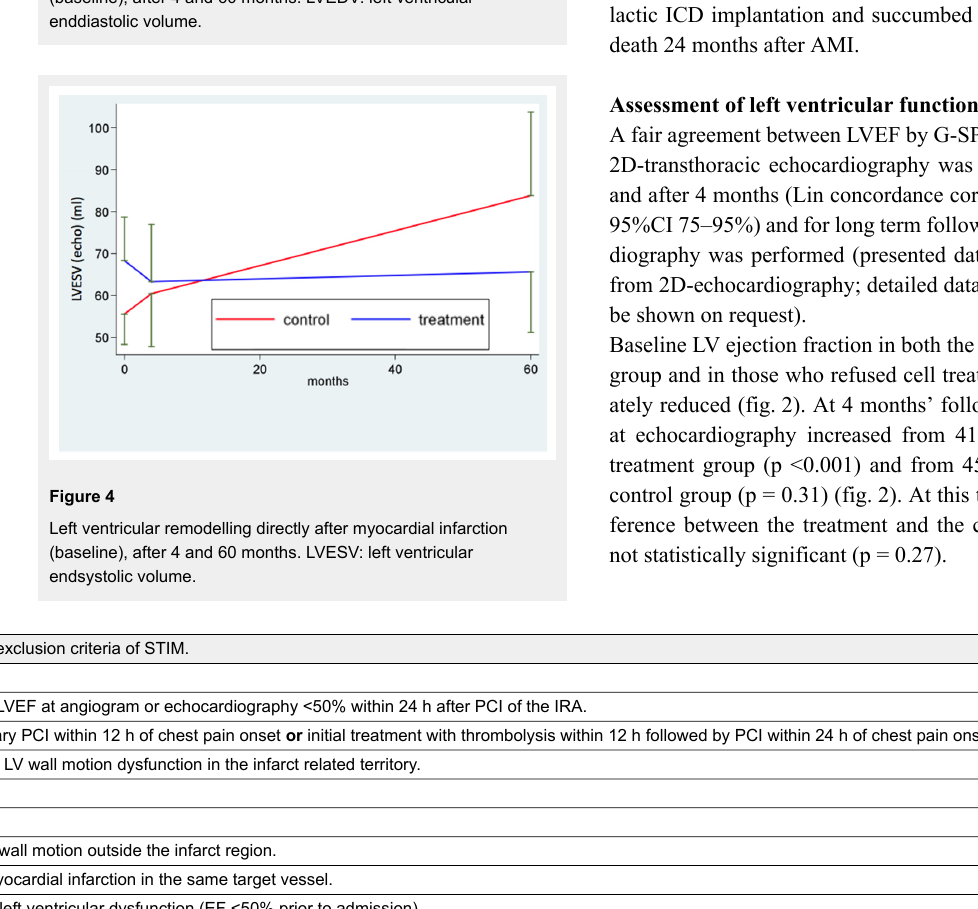
Left ventricular remodelling directly after myocardial infarction (baseline), after 4 and 60 months. LVEDV: left ventricular enddiastolic volume.